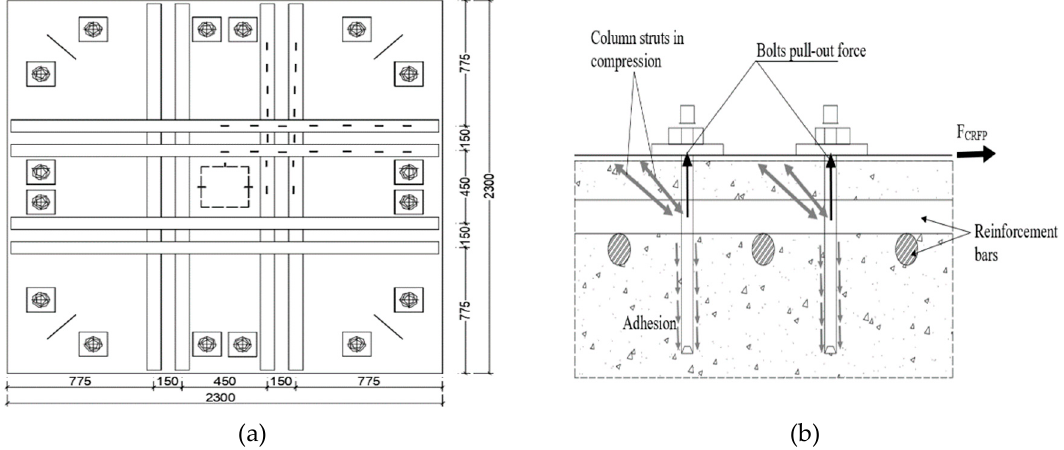
Figure 10. ( a ) Specimens with 8 strips bonded to the tension side with M10 anchor bolts and ( b ) anchor bolt failure mechanisms